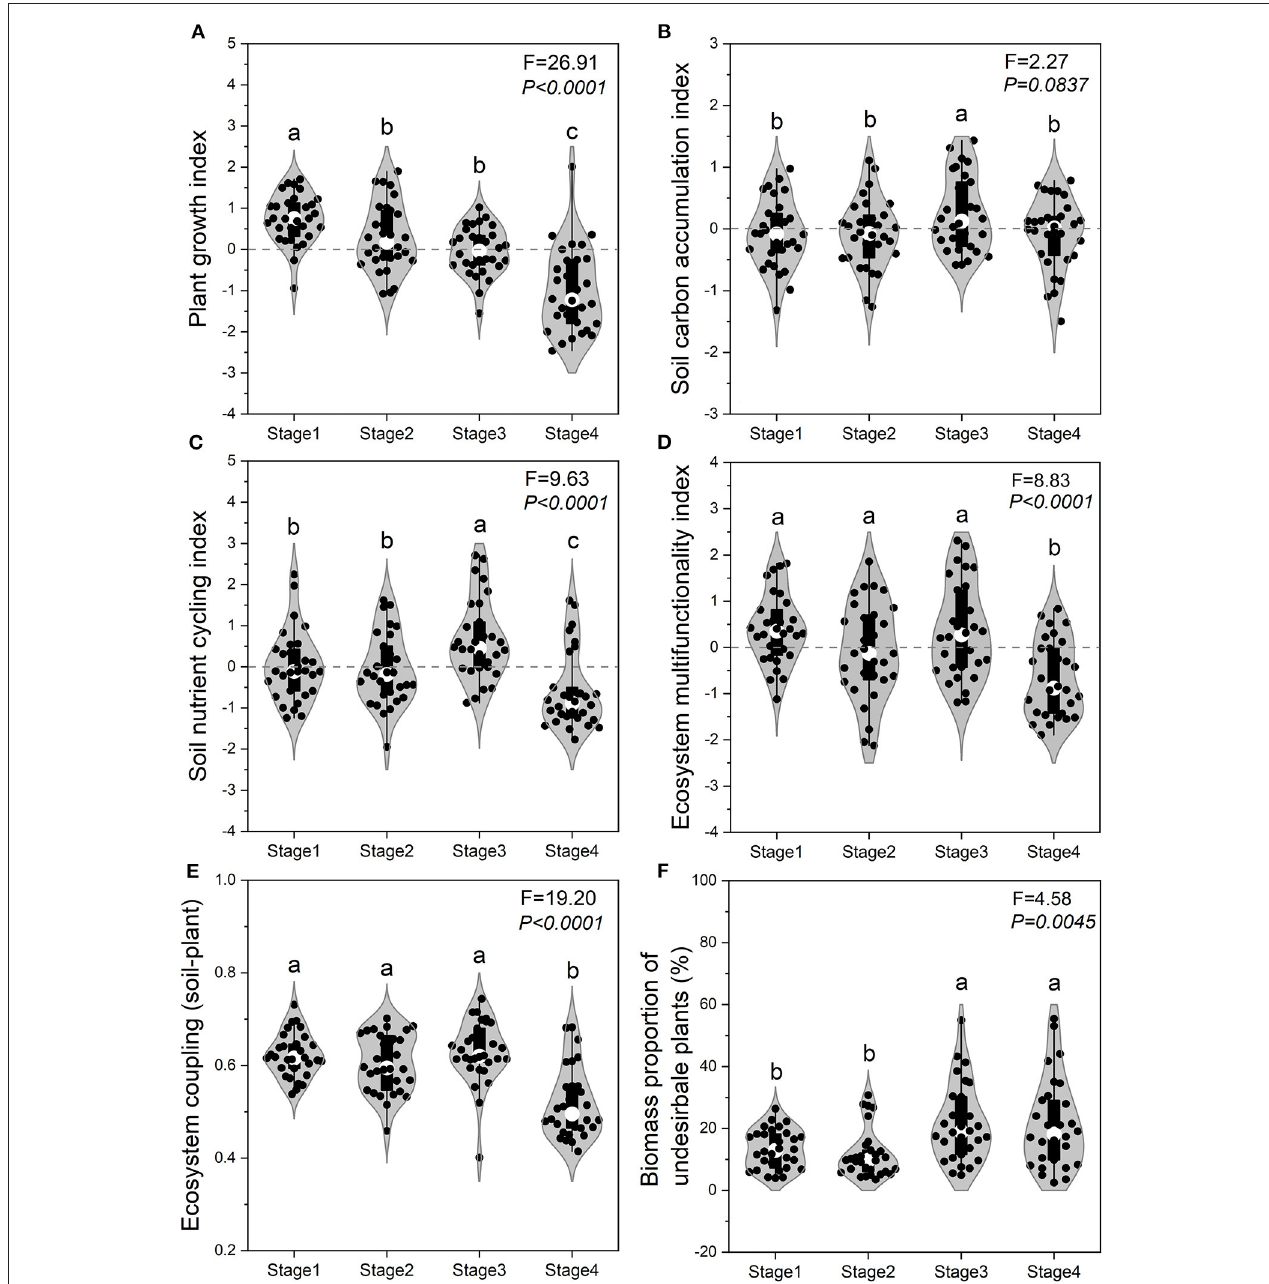
FIGURE 4 | Ecosystem functions across the four stages of succession. Plant growth index (A) , soil carbon accumulation index (B) , soil nutrient cycling index (C) , ecosystem multifunctionality index (D) , ecosystem coupling (soil-plant) (E) , and biomass proportion of toxic weeds (F) across the successional stages. Different lowercase letters above each violin plot indicate statistically significant differences between different succession